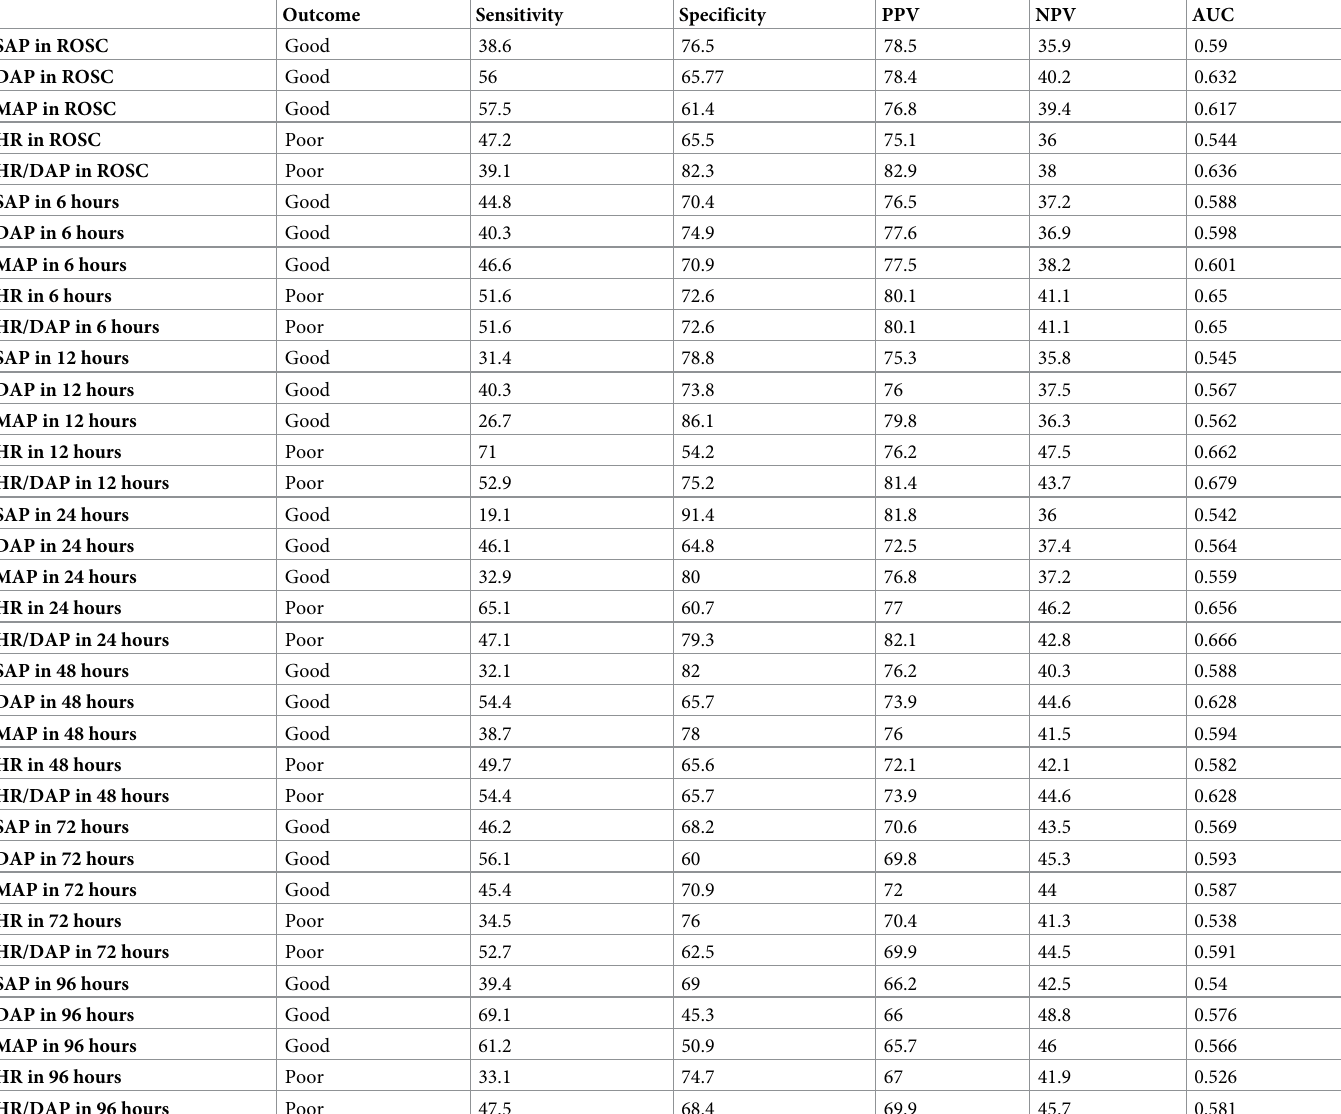
Table 3. Predictive accuracy of blood pressure and heart rate according to